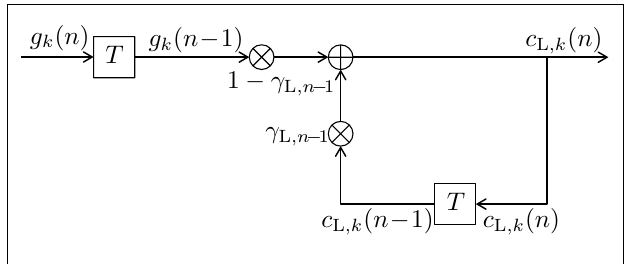
FIGURE 3 | Block diagram of a first-order infinite impulse response length (IIR) filter with transfer function H L ( f,n ) equivalent to (13) or (14). Elements T denote a delay of one trial. At the adder element ⊕ , updating of the weighted output γ L, n − 1 · c L, k ( n − 1) of the last trial n − 1 with the weighted input (1 − γ L, n − 1 ) · g k ( n − 1) of the last trial results in the current output c L, k ( n ). Note that via γ L, n − 1 · c L, k ( n − 1), all preceding inputs (and outputs) influence the current